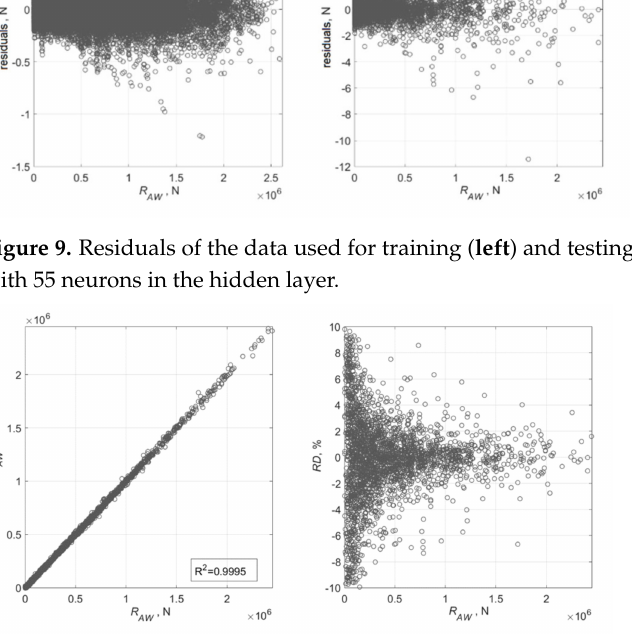
Figure 10. The regression plot ( left ) and RD ( right ) of the data used for the testing of the ANN with LM and BR with 55 neurons in the hidden layer.